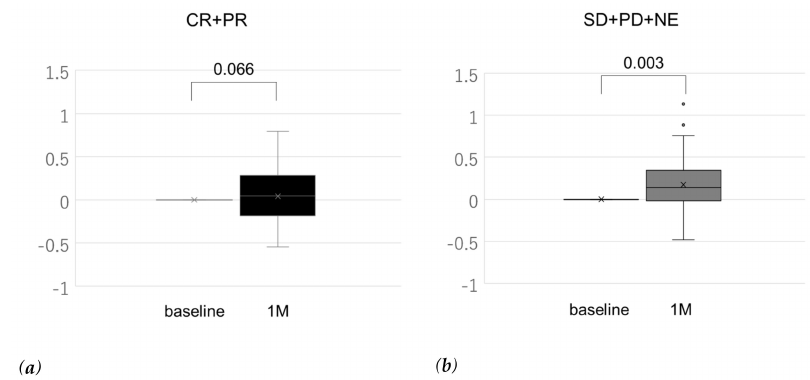
Figure 3. Change in albumin–bilirubin (ALBI) score from baseline to one month after treatment initiation according to the imaging response. ( a ) In imaging responders, the ALBI score did not show significant worsening ( + 0.11 ( − 0.14 to + 0.35), p = 0.066). ( b ) In imaging non-responders, the ALBI score showed significant deterioration ( + 0.14 ( − 0.02 to + 0.34), p = 0.003). The x-mark and black dot indicate the mean and outlier beyond 1.5 × interquartile range, respectively. CR, complete response; PR, partial response; SD, stable disease; PD, progressive disease; NE, no